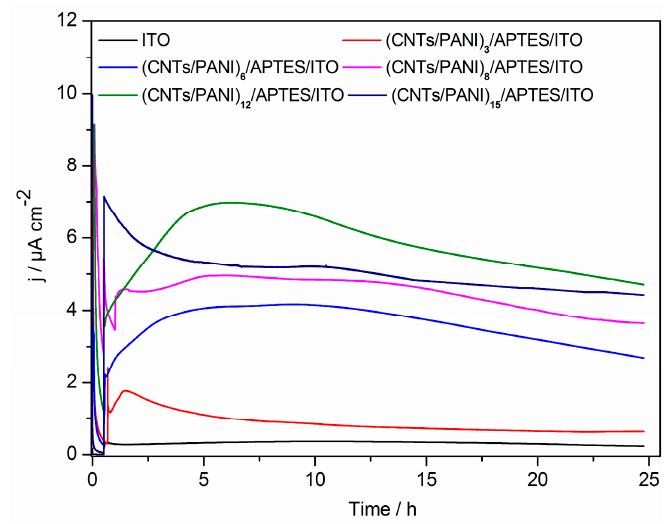
Figure 3. Current versus time measurement of current generation by S. loihica PV-4 cells on ITO electrode and (CNTs/PANI) n /APTES/ITO electrode poised at 0.2 V. n = 3, 6, 8, 12, 15.